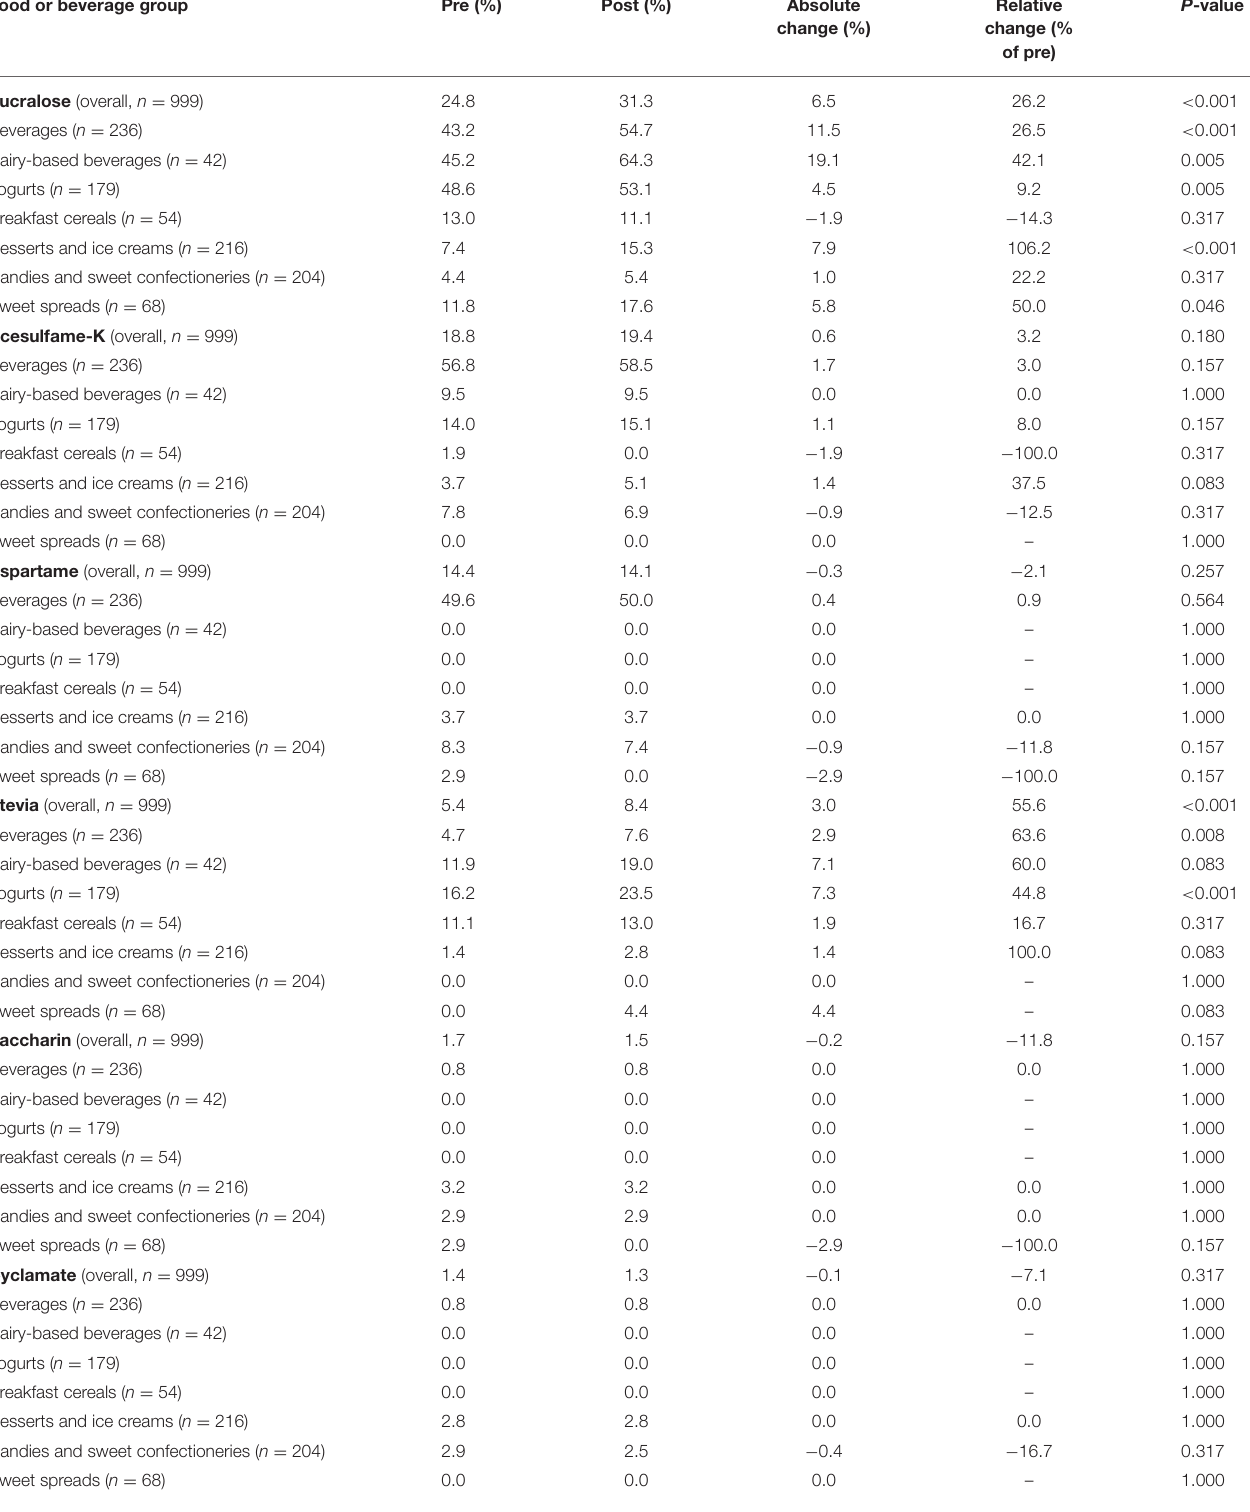
TABLE 2 | Changes in the frequency of each type of NNS in the pre- and post-implementation periods by food or beverage group. Food or beverage